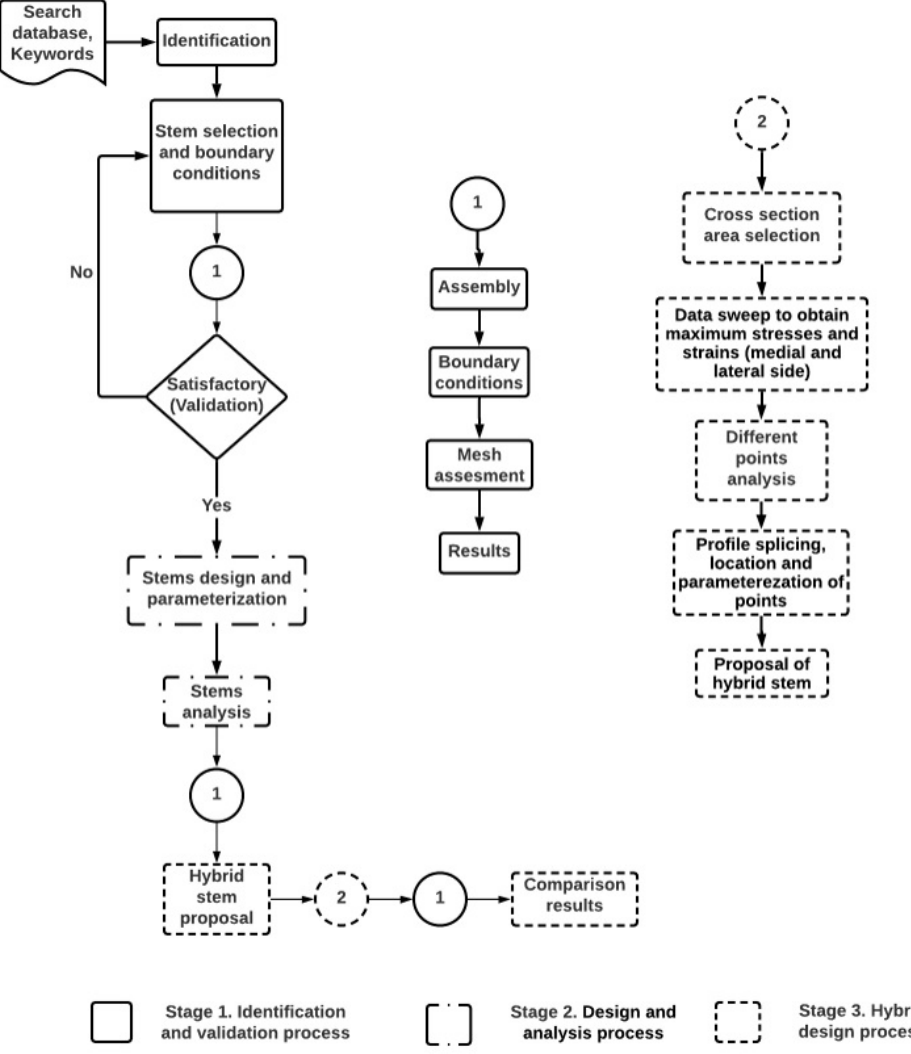
Figure 1. Assessment methodology to set a standard base for stem comparison and generate the proposed design of a hybrid prosthesis. It was divided into three stages: Stage 1. Identification and validation process. Stage 2. Design and analysis of the stems. Stage 3. Hybrid design